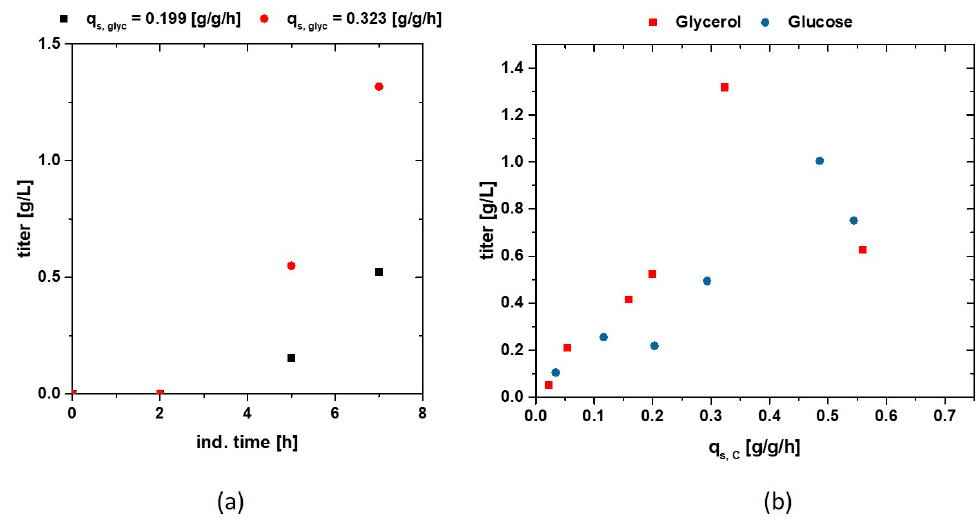
Figure 5. ( a ) Time dependence for two Inclusion Body (IB) titers starting from lactose addition to 7 h of induction; ( b ) Titers of the recombinant produced protein, after homogenisation of the inclusion bodies and a two-time washing plotted vs. the q s of glucose and glycerol; A trend can be seen in gaining more product when cultivations are carried out on glycerol compared to glucose, respectively.